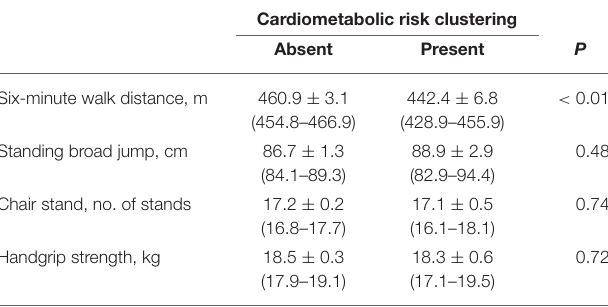
TABLE 3 | Estimated marginal mean values of the physical fitness tests of the study population according to cardiometabolic risk clustering. Cardiometabolic risk